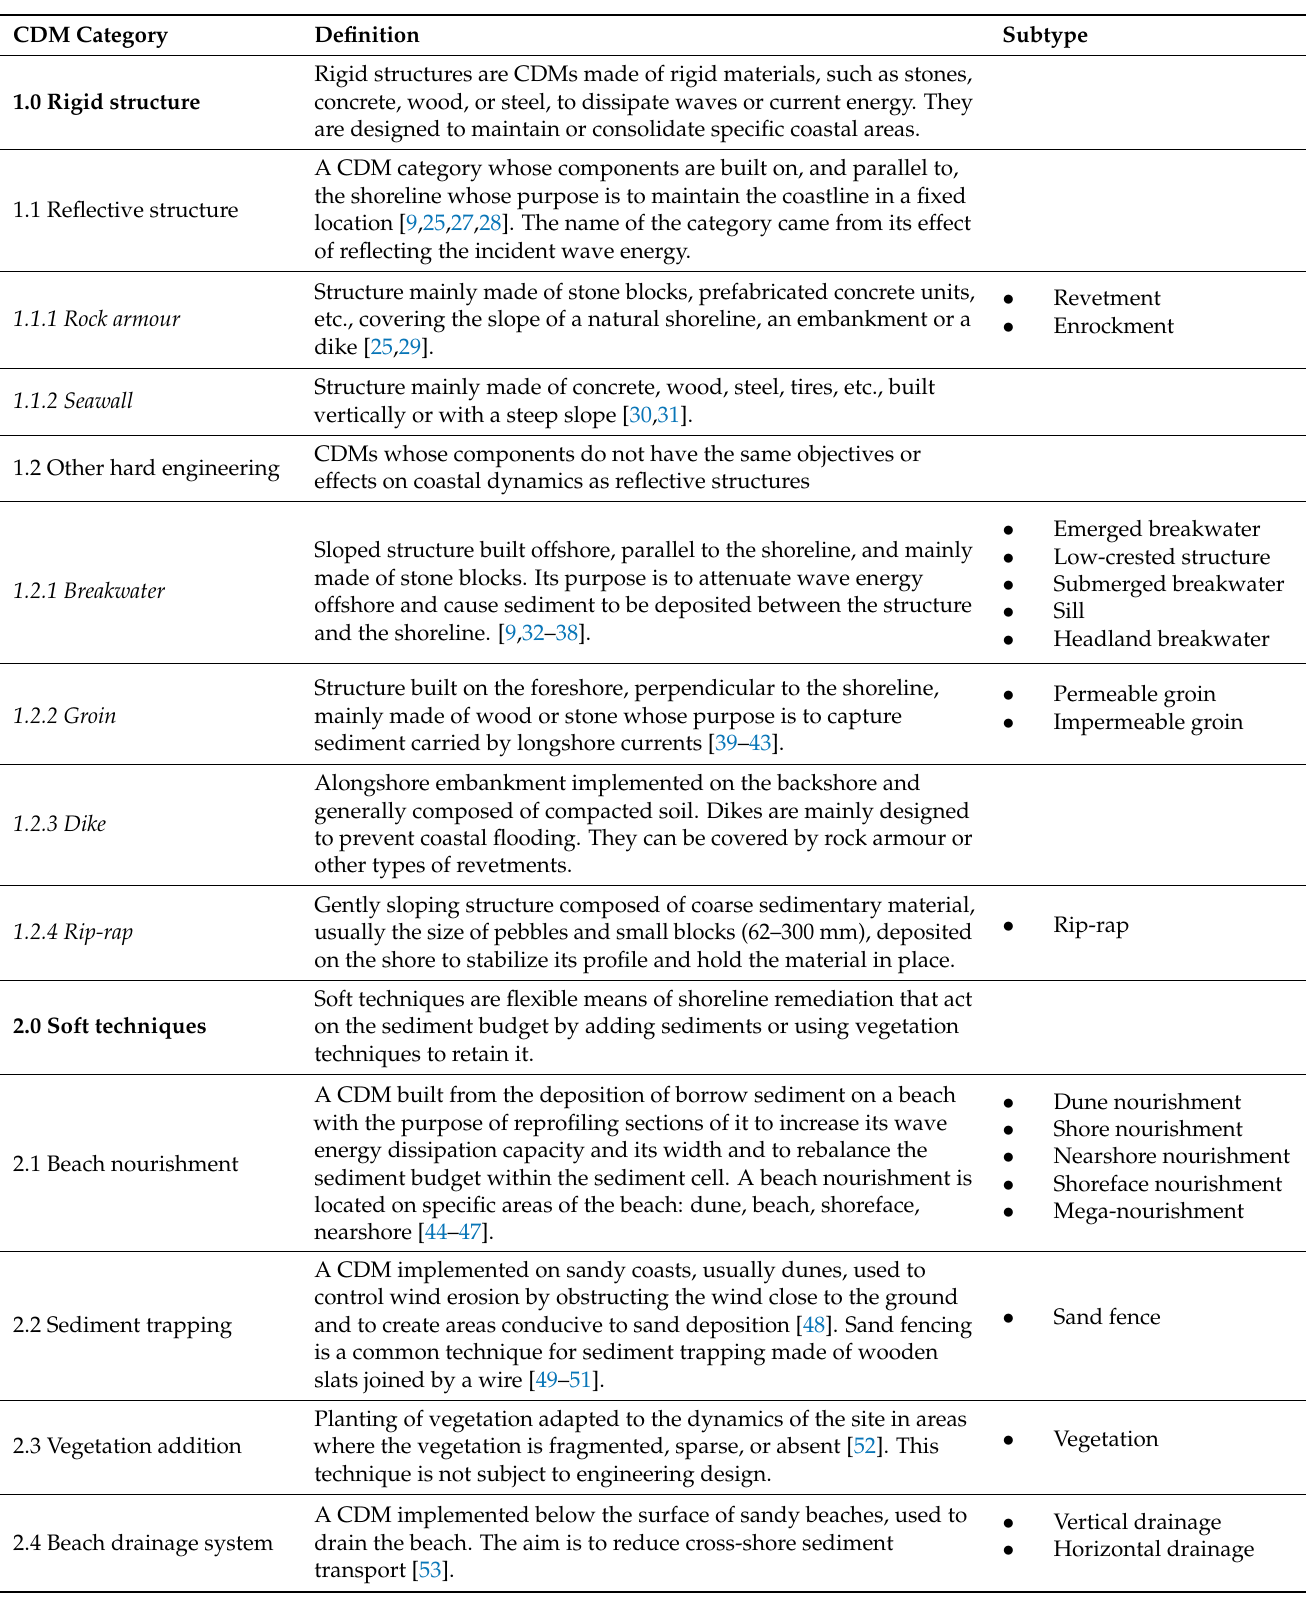
Table 1. Definition of coastal defence measure categories integrated into the meta-analysis ( category , subcategory, type